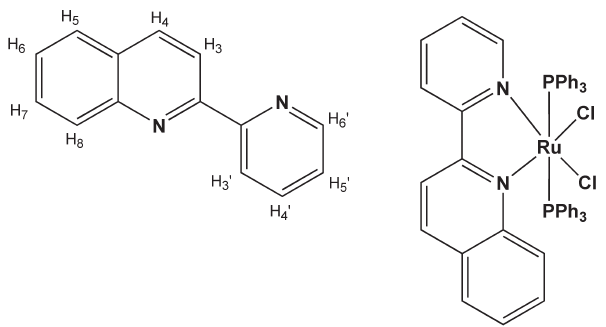
Scheme 1 : (a) The molecular structure of L1 including a numbering scheme of the hydrogen atoms. (b) The structure of complex 1